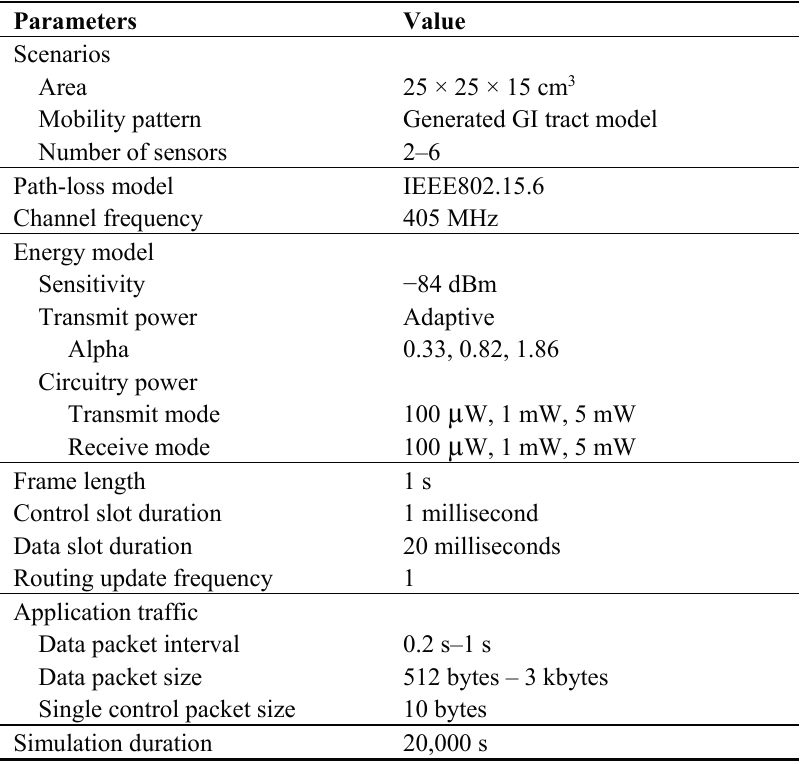
Table 4. Parameters used in simulation.